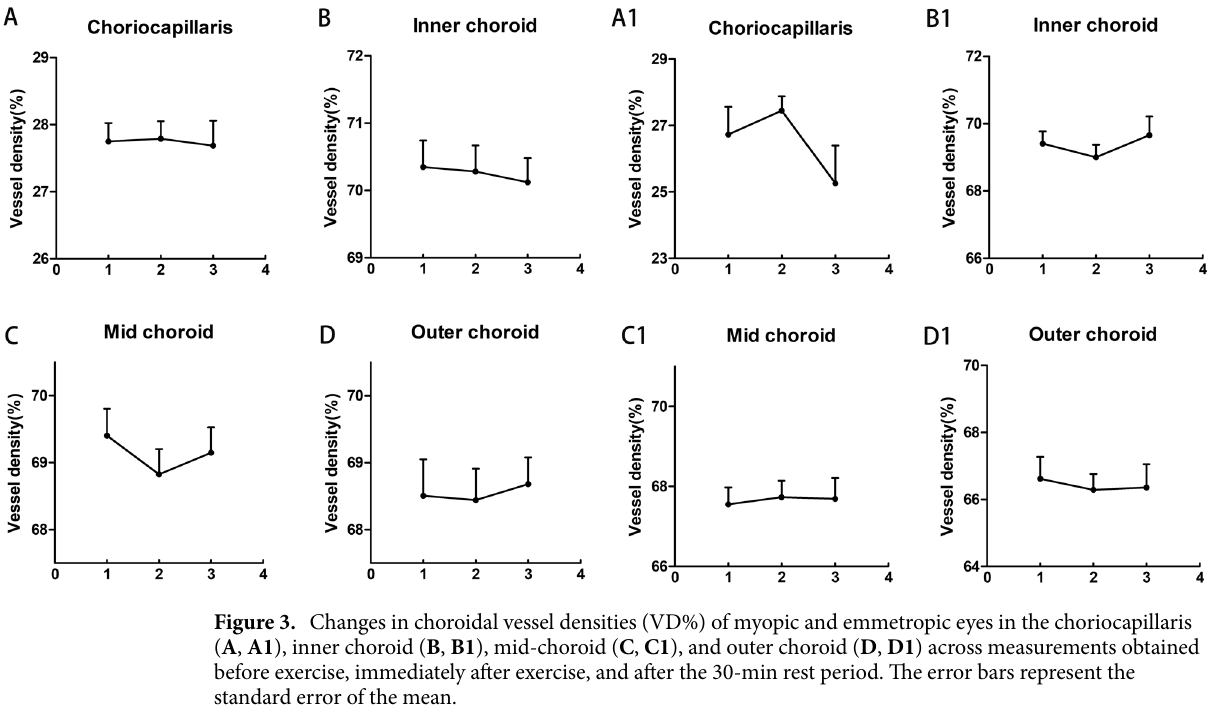
Figure 3. Changes in choroidal vessel densities (VD%) of myopic and emmetropic eyes in the choriocapillaris ( A , A1 ), inner choroid ( B , B1 ), mid-choroid ( C , C1 ), and outer choroid ( D , D1 ) across measurements obtained before exercise, immediately after exercise, and after the 30-min rest period. The error bars represent the standard error of the mean.